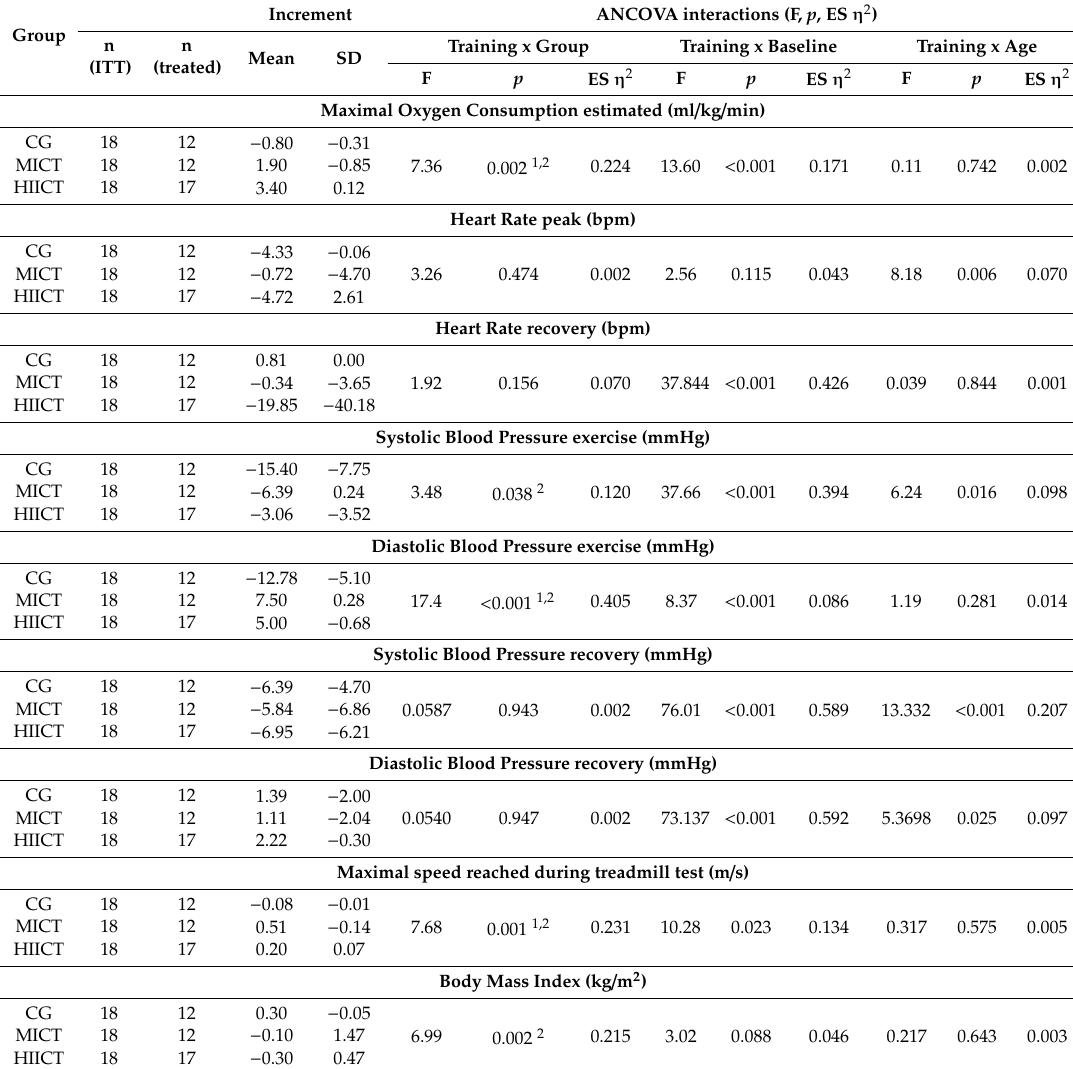
Table 2. ANCOVA interactions on HIICT, MICT, and